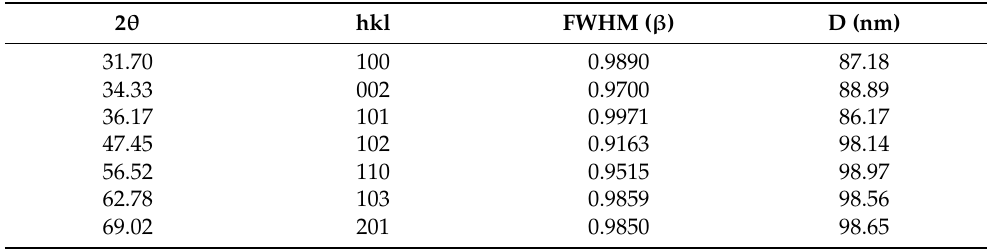
Table 1. XRD-based parametric calculation for the determination of the average particle size of the ZnPs.